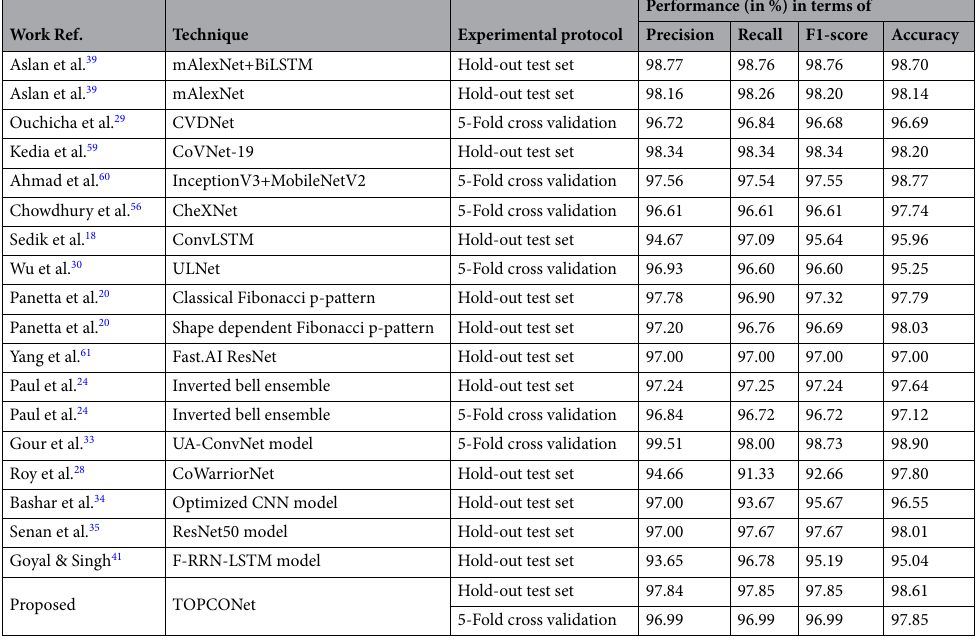
Table 8. Performance comparison of the proposed method with some state-of-the-art models on the Dataset-2.